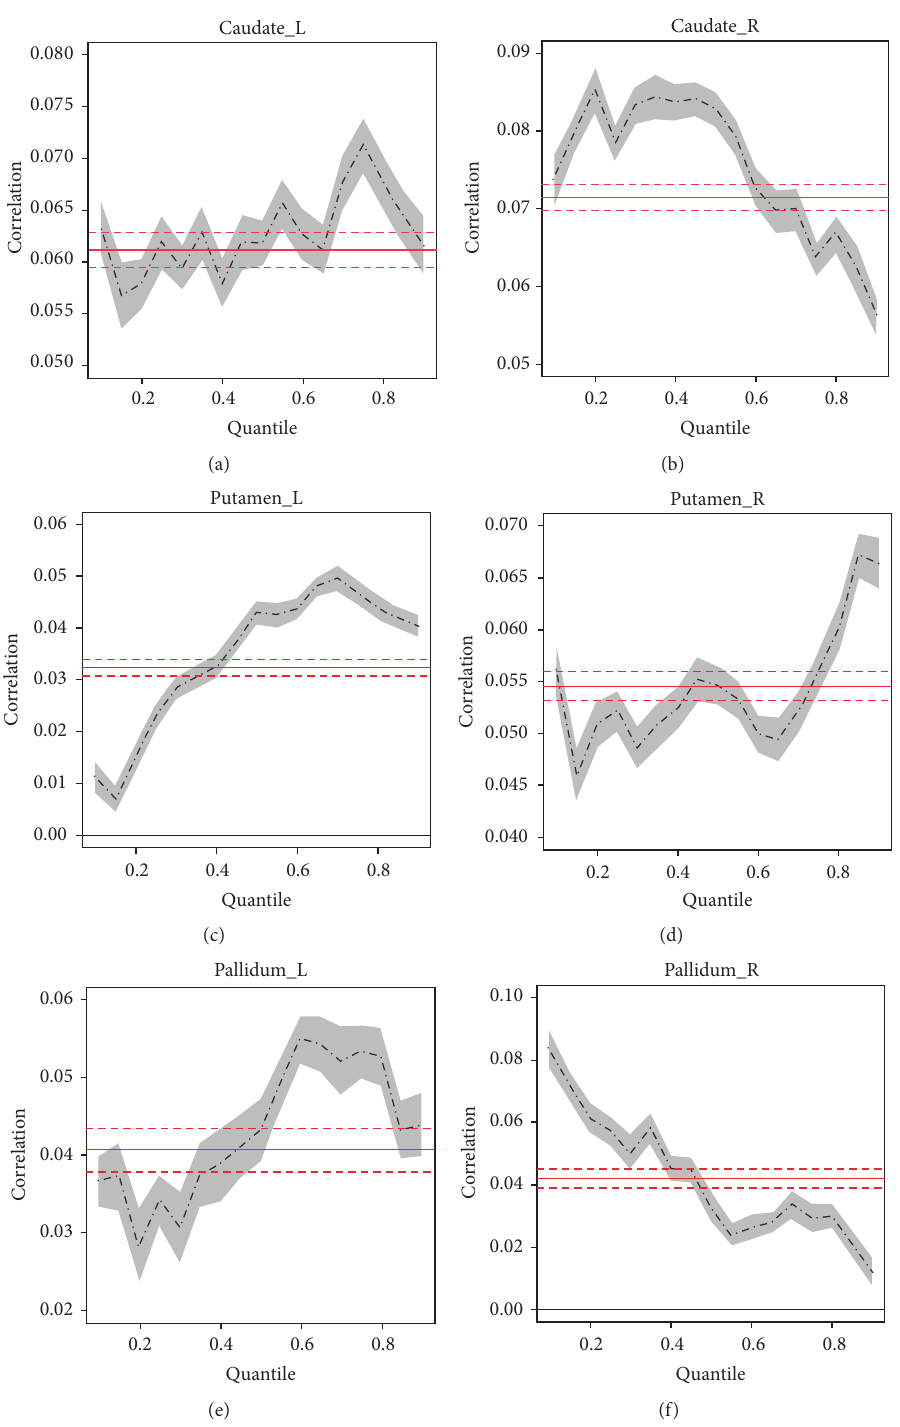
Figure 2: Results of quantile analysis from comparisons of coefficients of cross-correlation (FC) between minimal (first 100s) and significant (last 100 s) fatigue stages in bilateral caudate, putamen, and pallidum. Comparisons were made at each quantile of the distribution curve between minimal and significant fatigue conditions in each ROI. ANOVA results were plotted in red (solid line = mean; dotted line = 95% confidential